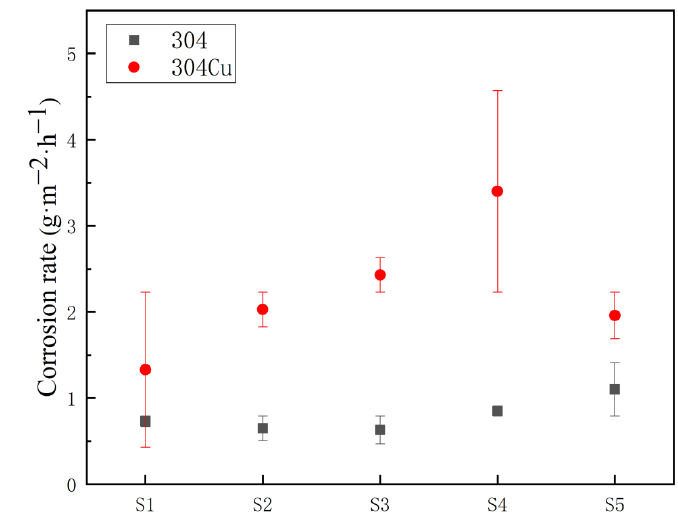
Figure 8. Corrosion rate from weight-loss measurements after a 72 h FeCl 3 immersion test. Table 3. Corrosion rates (CRs) from weight-loss measurements and ICP results.